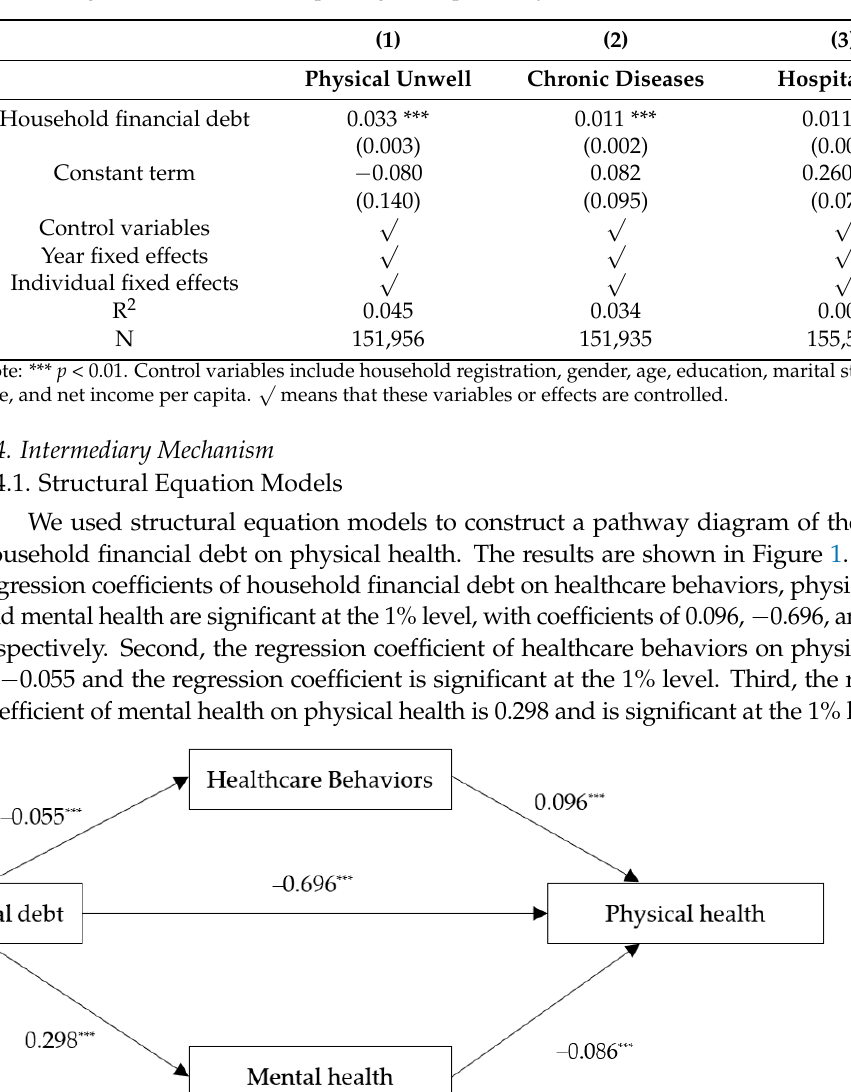
Table 6. Intermediary mechanism